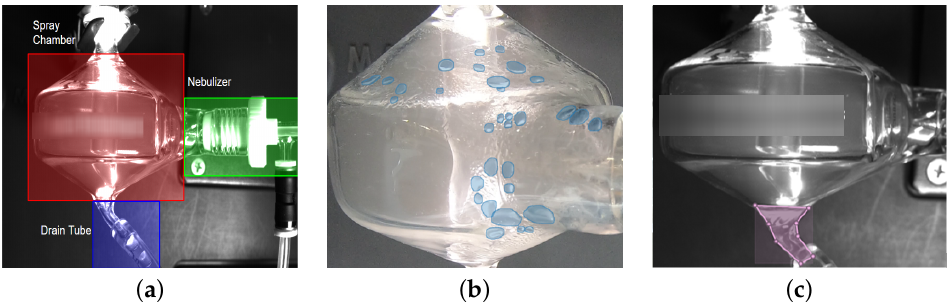
Figure 1. ( a ) Region of interest from a typical spectrometer device where most incidents happen. It contains a spray chamber, a nebulizer, and a drain tube connected to the chamber. ( b ) Beads on the surface of the spray chamber. This is the first type of incident to be detected. In the image, the beads are labeled with instance masks. ( c ) Flooding at the bottom of the spray chamber. This is the second type of incident to be detected. The flooding area is indicated with a pink